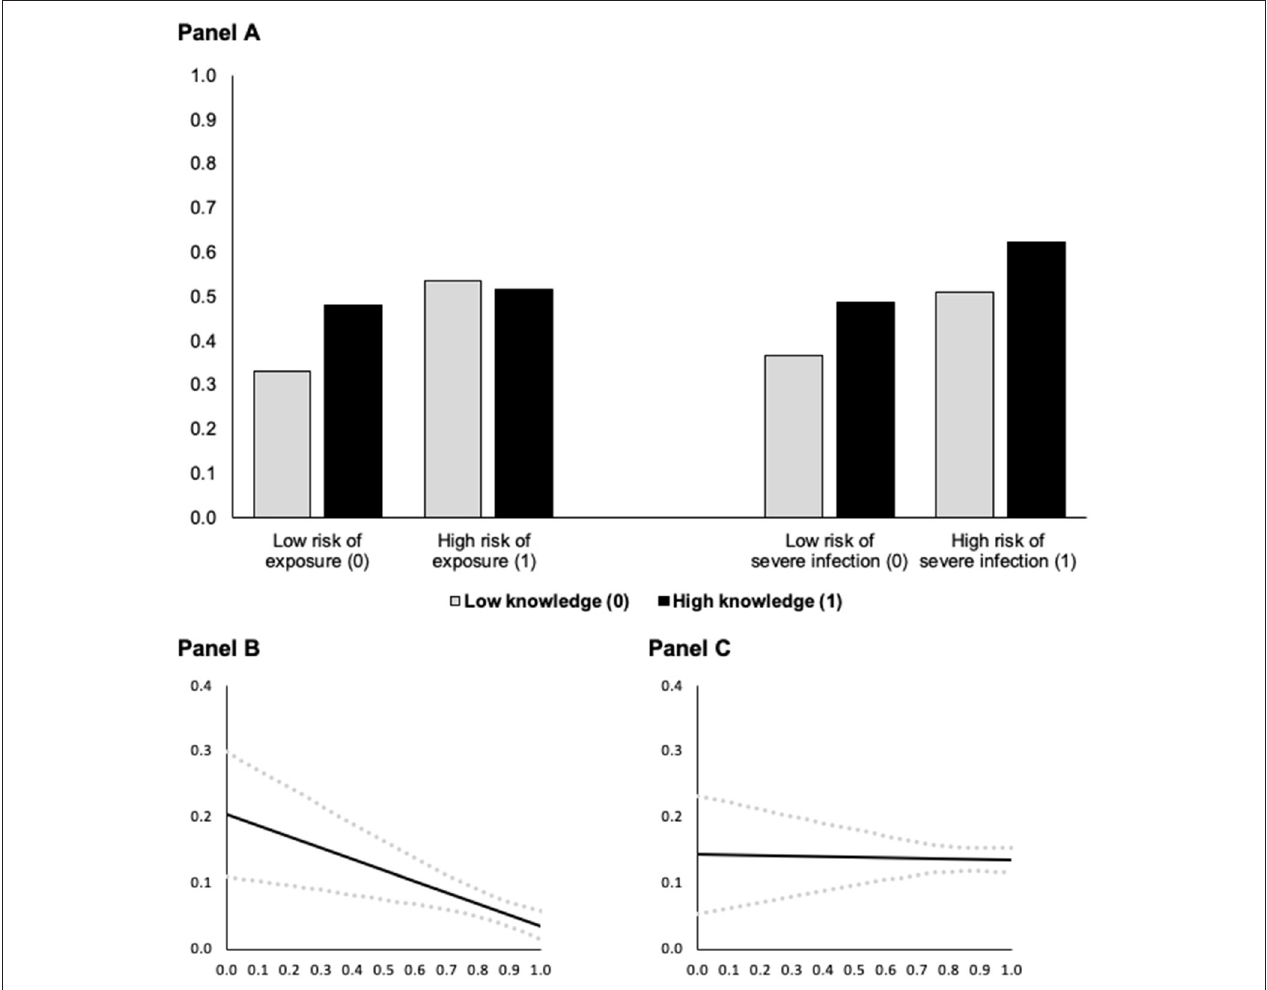
FIGURE 2 | Predicted COVID-19 threat as a function of risk group membership (A) at different levels of knowledge about COVID-19 and conditional effect of risk of exposure (B) and of severe infection (C) on COVID-19 threat as a function of knowledge about COVID-19 (based on Models 1 and 2 in Table 3 , N = 4,096). In (A) , predictions are for men who are 18 years old. In (B,C) , the black solid lines ( — ) indicate the conditional effect of risk group membership from the lowest (0) to the highest (1) level of knowledge about COVID-19 and dotted gray lines ( • • • ) indicate the upper and lower 95% confidence interval; all Johnson-Neyman values are statistically significant ( p <